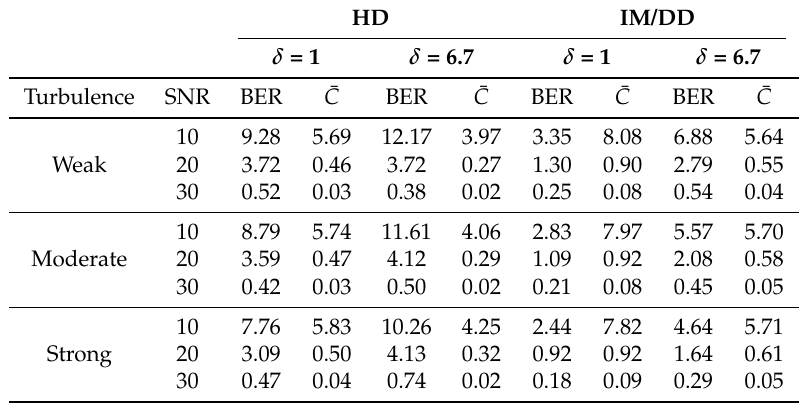
Table 1. Performance degradation percentage due to the noise propagation effect in comparison with the approximate results from γ a